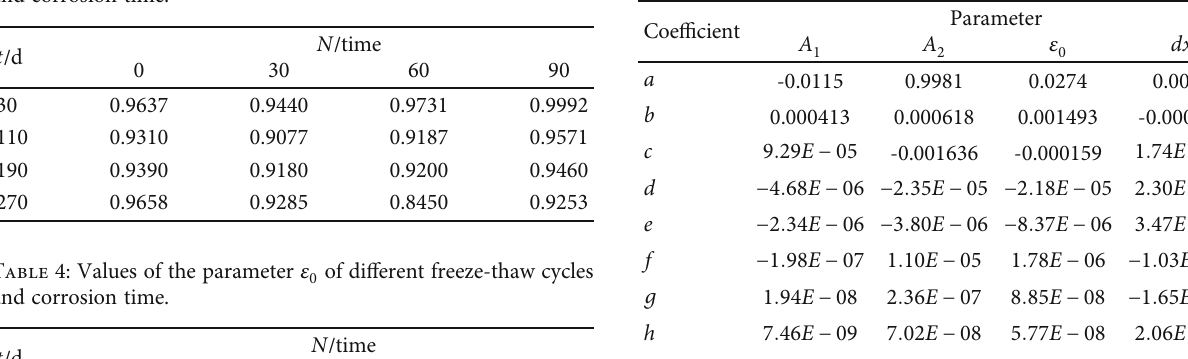
Table 6: Fitting coe ffi cients a , b , c , d , e , f , g , and h